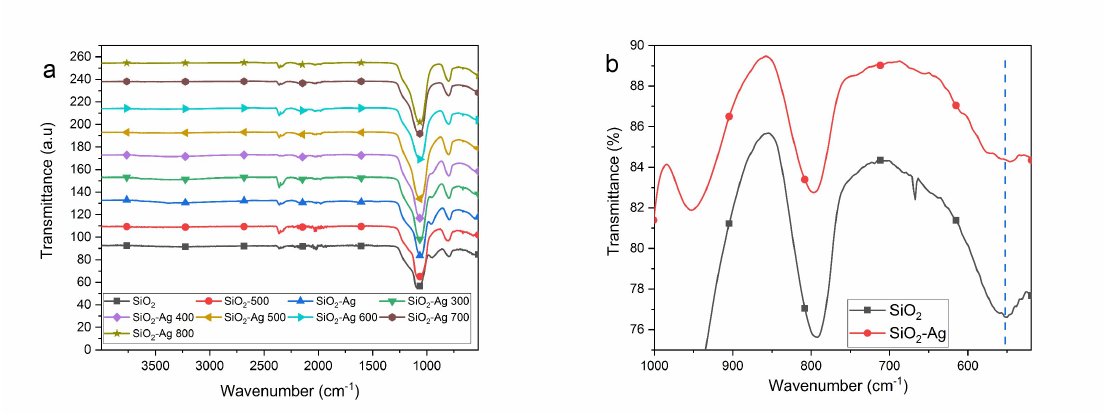
Figure A3. FTIR spectra of ( a ) all SiO 2 -Ag composite samples, SiO 2 and a SiO 2 sample annealed at 500 ◦ C. A close up of the Si–O–Ag interaction at 554 cm − 1 of ( b ) the as-prepared SiO 2 -Ag and SiO 2 for